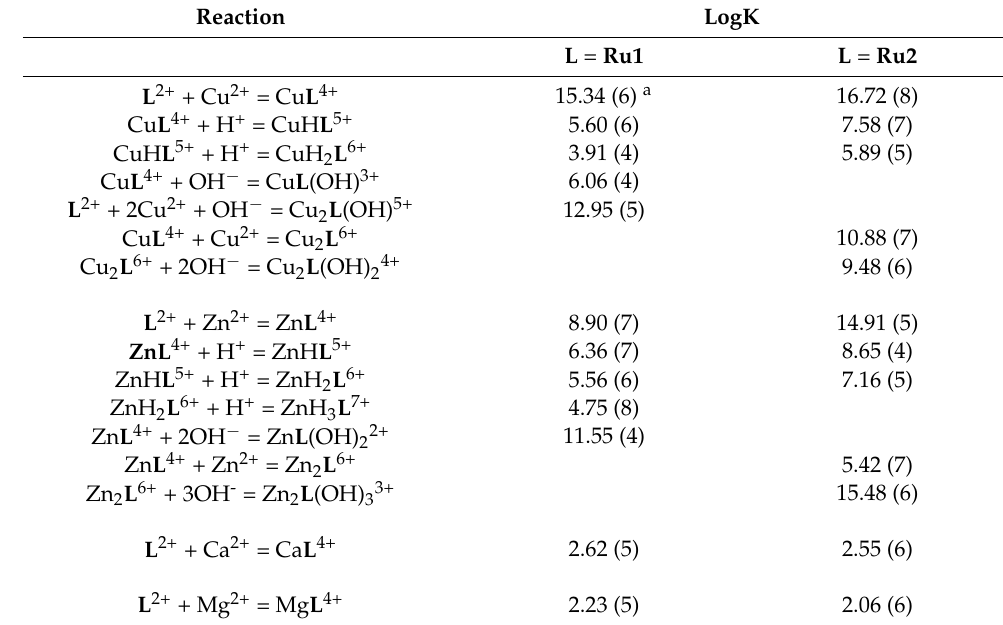
Table 1. Stability constants of Cu(II), Zn(II), Ca(II) and Mg(II) complexes formed by Ru1 2+ and Ru2 2+ determined by means of potentiometric measurements in NMe 4 Cl 0.1 M, at 298.1 ± 0.1 K.